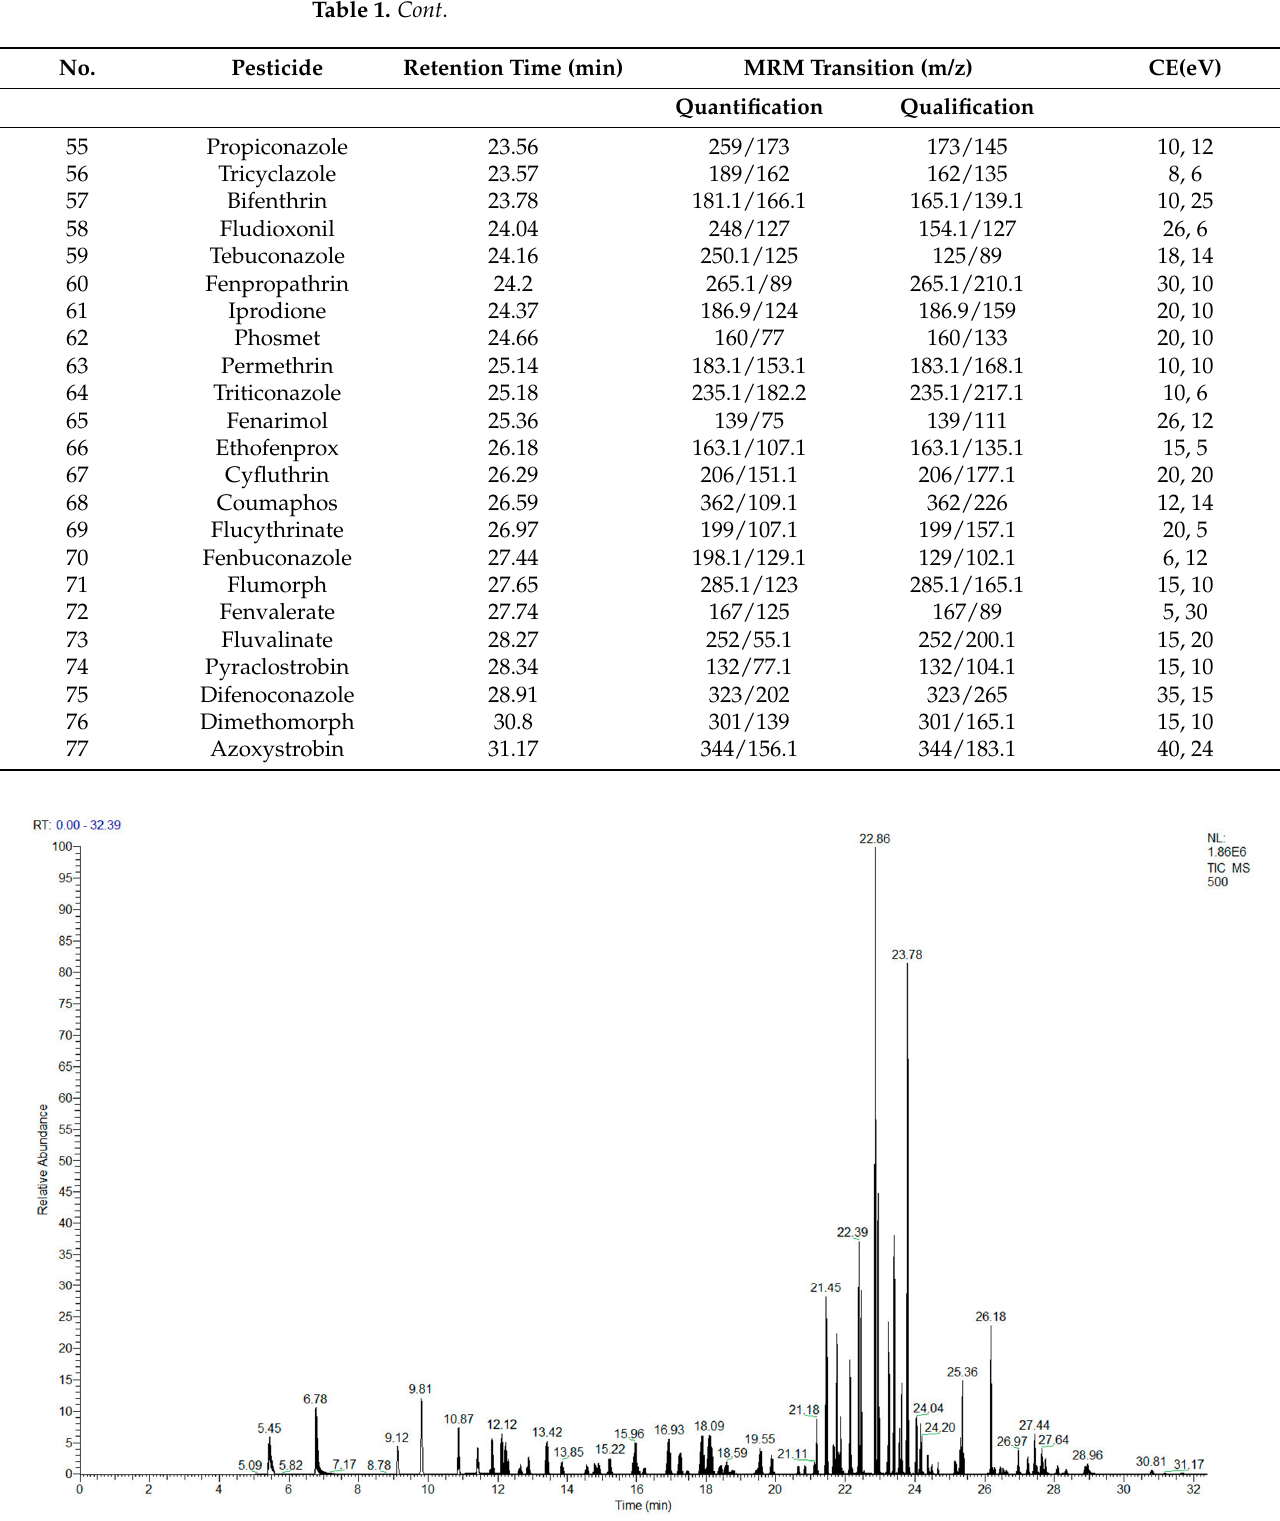
Figure 1. Total ion chromatogram (TIC) of 77 pesticide standards.